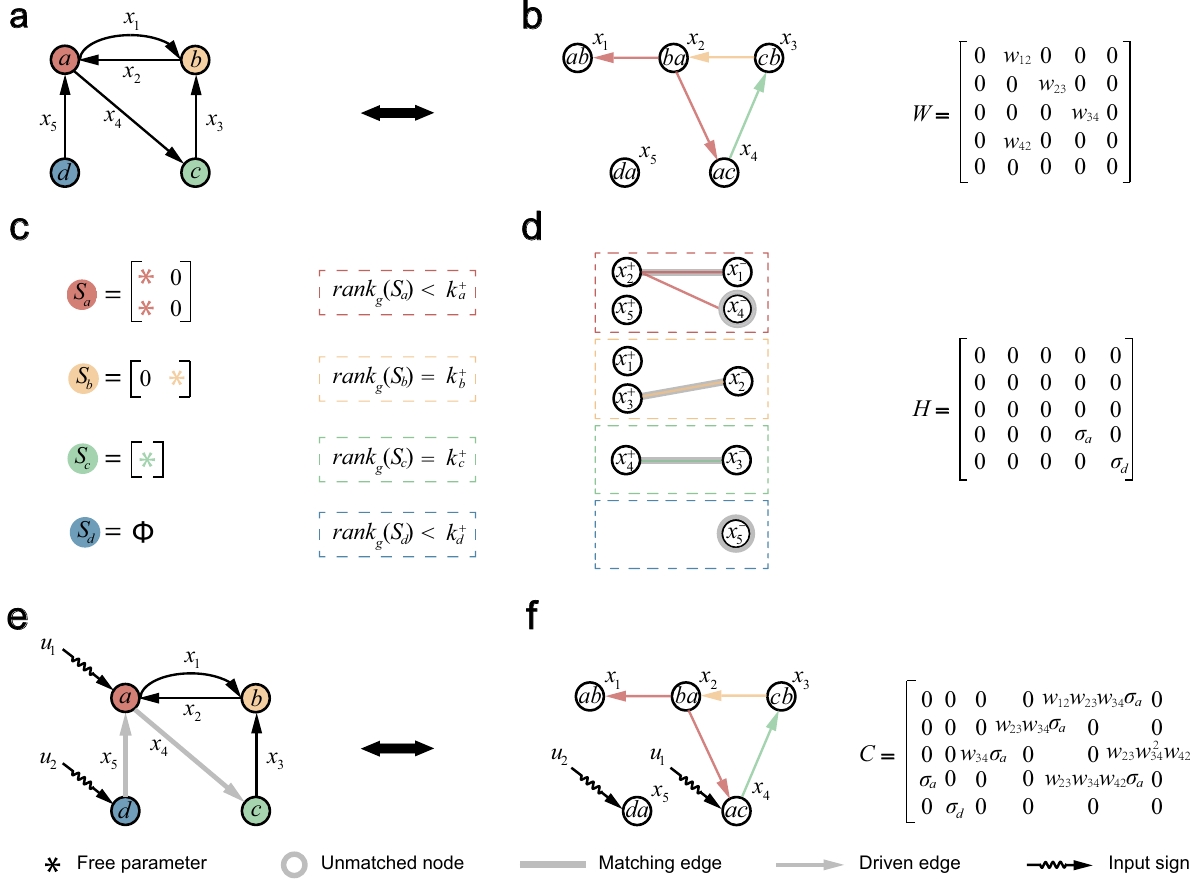
Figure 1. Structural controllability of general edge dynamics. ( a ) A directed network G with 4 nodes and 5 edge states { x 1 , x 2 , x 3 , x 4 , x 5 } in GED. ( b ) The trimmed line graph L ( G ′ ) of G . The colors of edges in L ( G ′ ) correspond to those of the nodes in ( a ). ( c ) The switching matrices { S a , S b , S c , S d } in G . ( d ) The bipartite graph H ( G ) of L ( G ′ ) with 4 matching blocks. ( e ) Driver nodes ( v a and v d ), driven edges ( x 4 and x 5 ) and input signals ( u 1 and u 2 ) for controlling the GED of G . ( f ) Driver nodes ( x 4 and x 5 ) and input signals ( u 1 and u 2 ) for controlling the nodal dynamics of L ( G ′ )